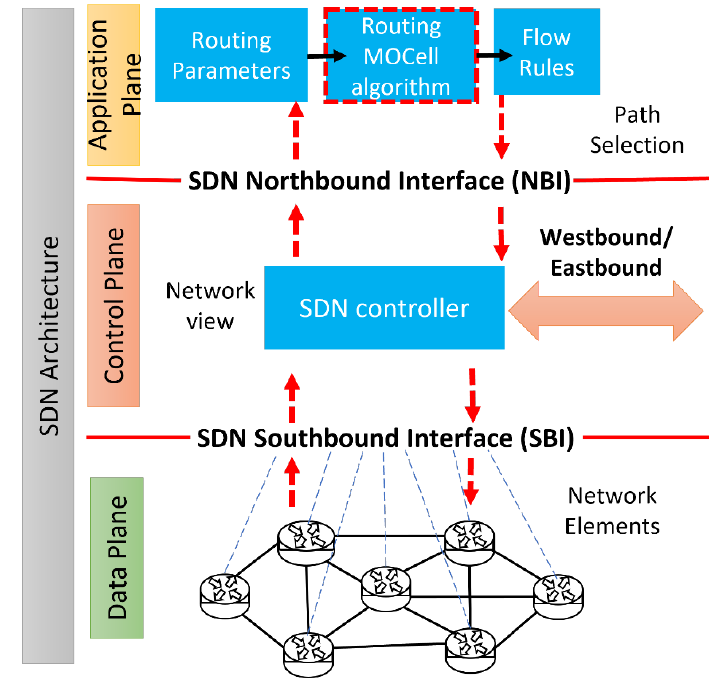
Figure 2. Routing architecture for